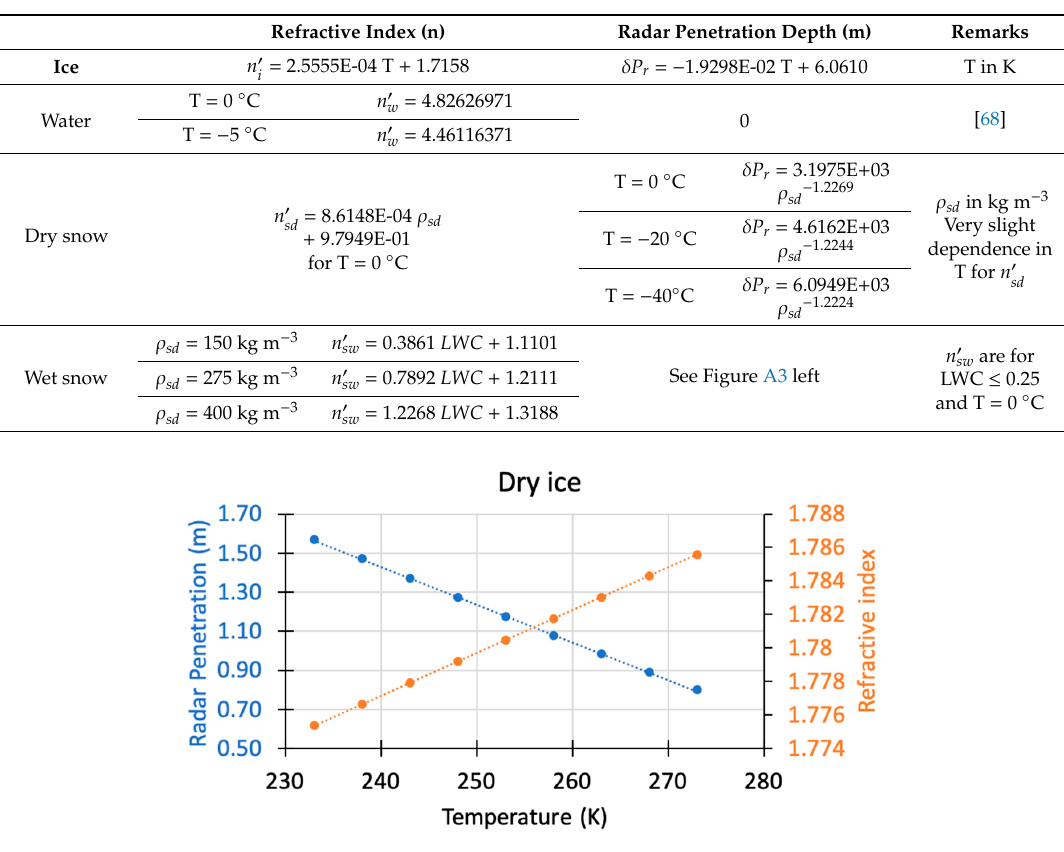
Figure A1. Radar penetration depth (m) (left axis) and refractive index (right axis) vs. temperature (K) for dry ice.